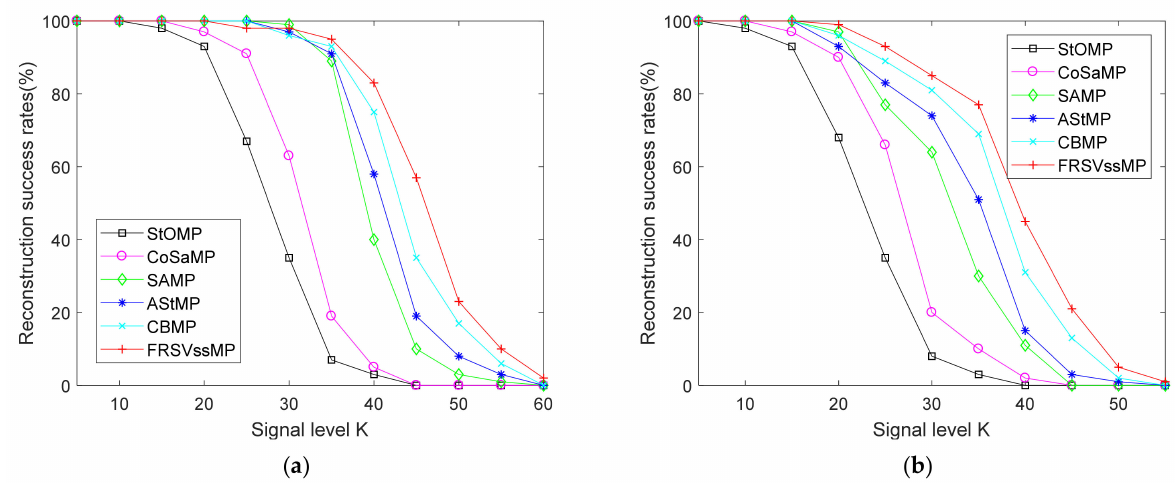
Figure 5. Reconstruction success rates vs. the sparsity level ( a ) Synthetic signals; ( b ) Real signals.